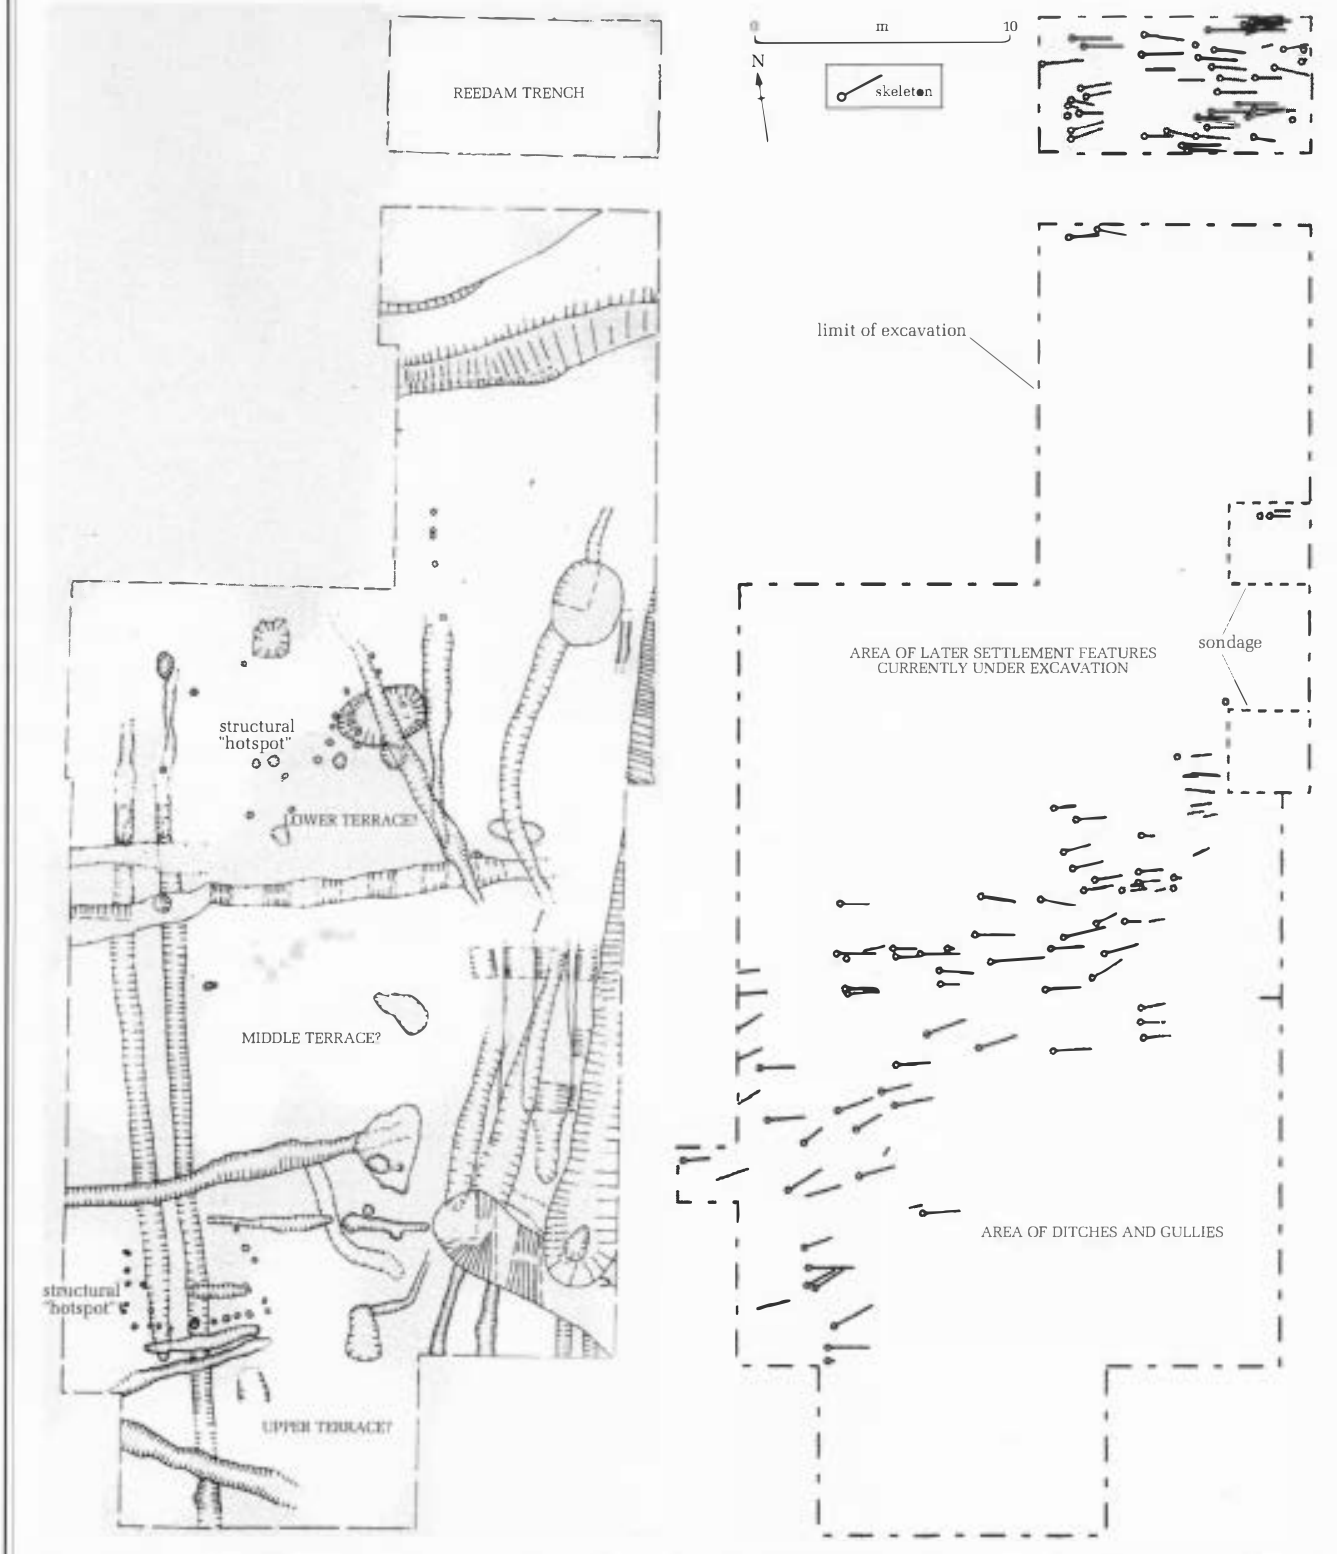
Figure 2 Plans of the Boneyard-Reeddam excavation site showing (left] structural "hots pots" where there is evidence of ditches, pits, post-holes, stone spreads and terrace-like features, and (right] the positions of underlying human burials. The top of the slope of the Boneyard field is to the south and the waterlogged Reed dam trench to the north. The site is heavily disturbed, but there appear to be three terraces cut into the slope and two structural "hotspots" where Anglo-Saxon buildings once